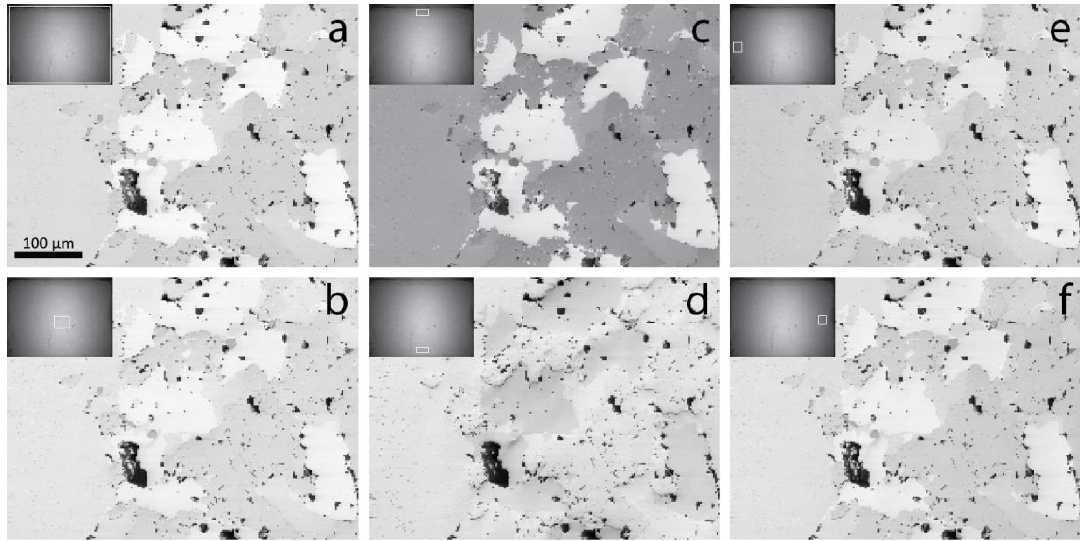
Figure 5. Reconstructed images from an EBSD scan at E 0 = 20 kV acquired from a mineral slag sample with the pixel array areas on the reference image (inset) as highlighted by the white squares. ( a ) Full reference image area; ( b ) small area at the center; ( c ) small area from top-center; ( d ) small area from bottom-center; ( e ) small area from left-center and ( f ) small area from right-center. The scalebar displayed on the image ( a ) applies to all the other images of the figure. DOUBLE COLUMN.